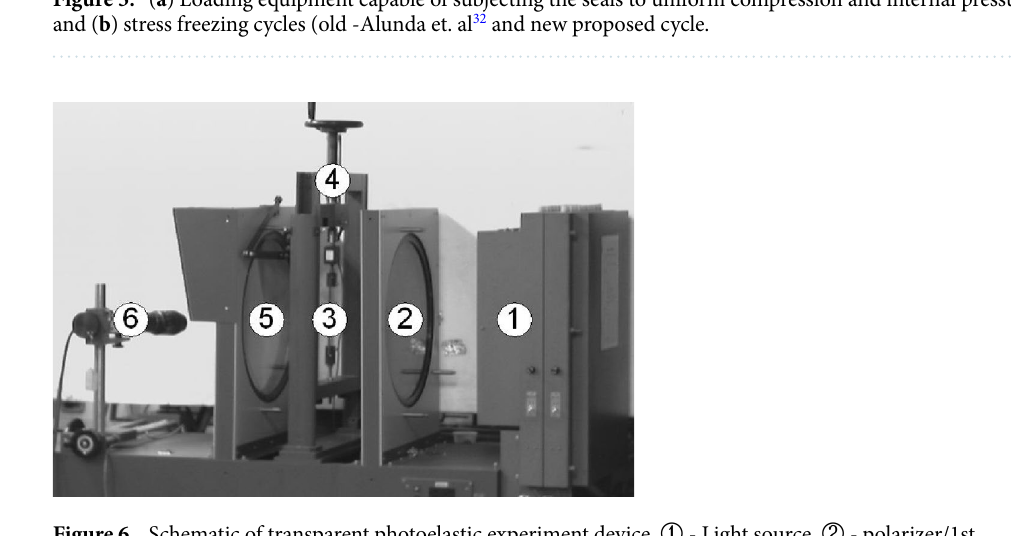
Figure 6. Schematic of transparent photoelastic experiment device. ① - Light source, ② - polarizer/1st quarter-wave plate, ③ - specimen, ④ - loading device, ⑤ - analyzer/2nd quarter-wave plate ⑥ - high-speed